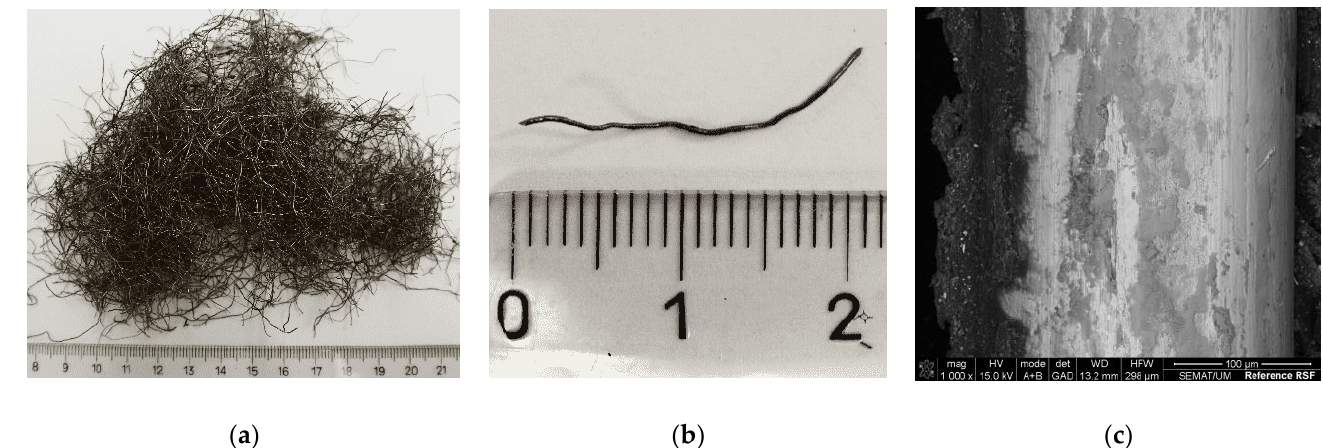
Figure 1. Recycled steel fibers (RSFs): ( a ) general view of multi RSFs; ( b ) general view of the geometry of a single RSF; and ( c ) SEM micrograph of the surface of a single reference RSF (magnification: 1000×) [3].